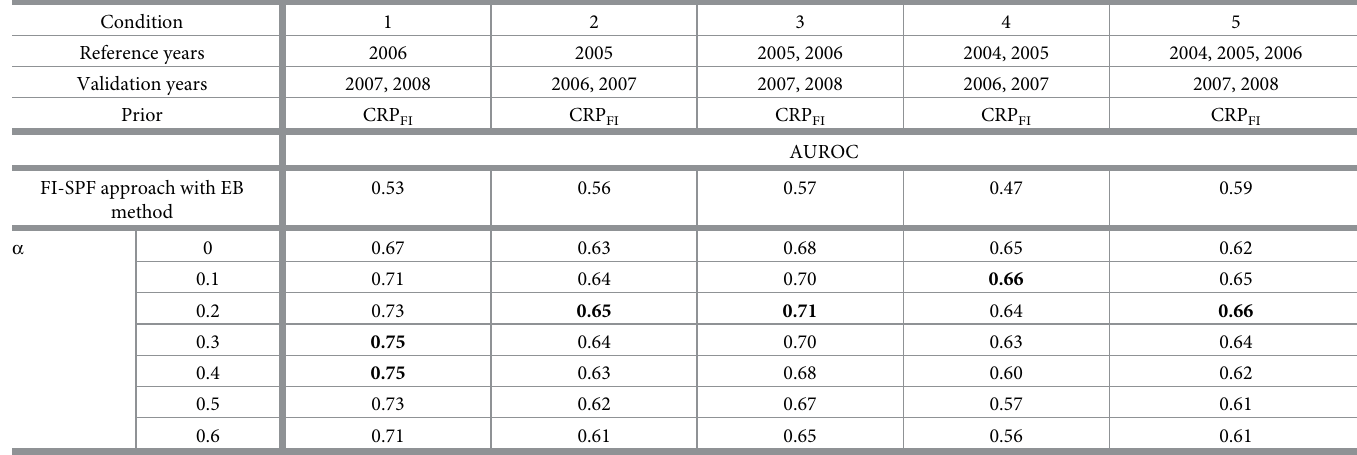
Table 5. Performance in detecting reproducible fatal collision sites on six routes with α = 0 to 0.6 with CRPFI priors for various reference and validation